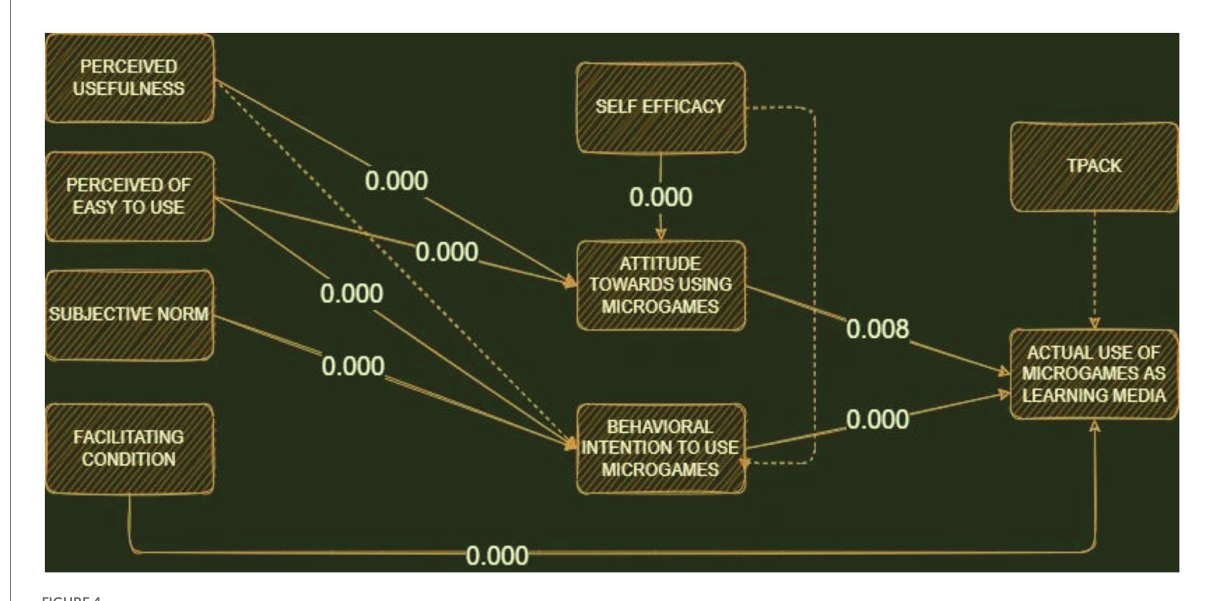
FIGURE 4 Final model with p -value, the dotted line shows the path is not significant.